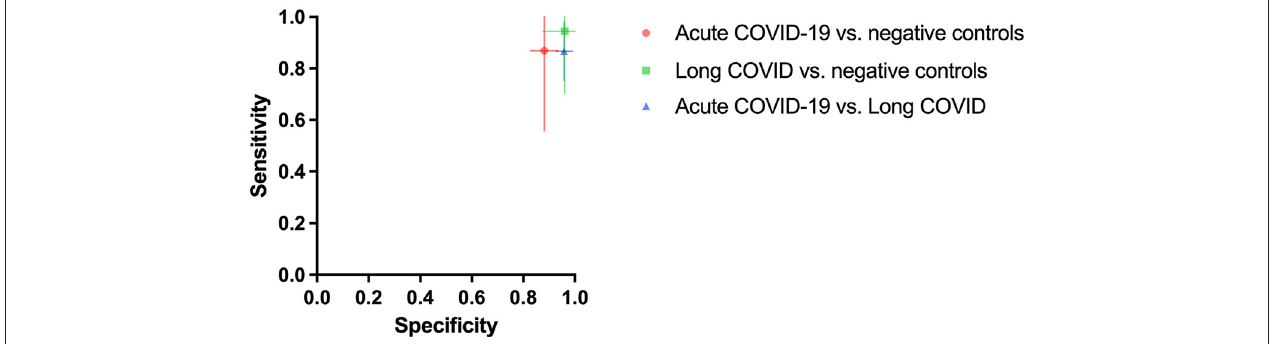
FIGURE 1 | Mean diagnostic specificity and sensitivity for all dogs for acute COVID-19 vs. negative control (red circle), Long COVID vs. negative control (green square), and acute COVID-19 vs. Long COVID (blue triangle) samples, respectively. The 95% confidence intervals of the means for specificity and sensitivity are shown with horizontal and vertical bars,